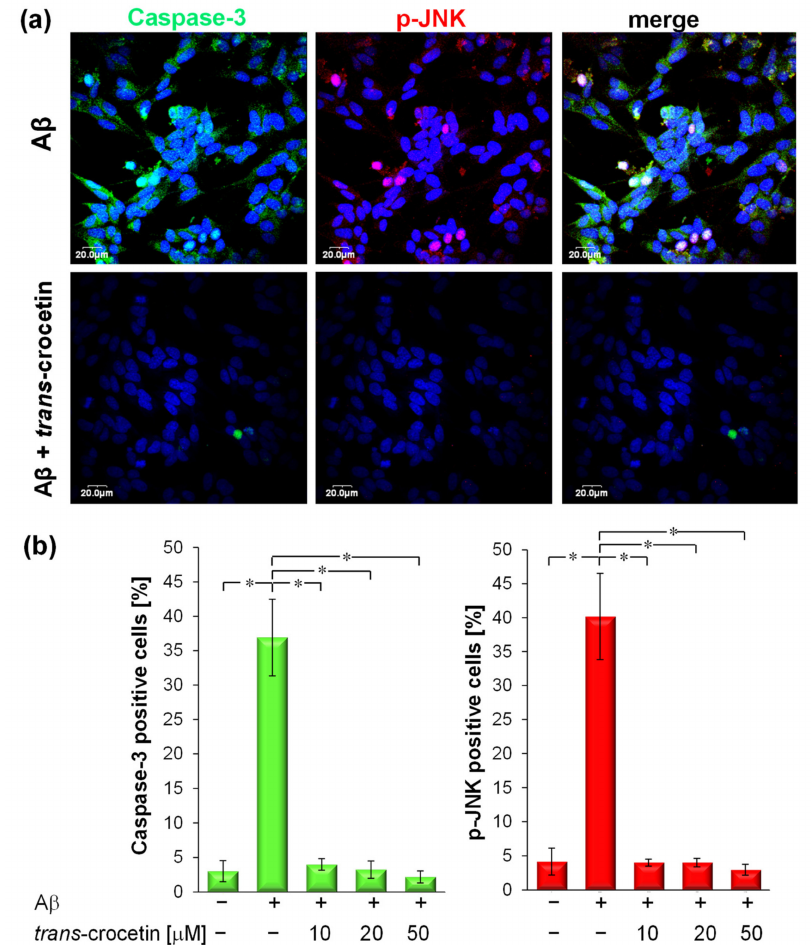
Figure 5. Trans-crocetin defended neurons against A β -induced apoptosis: ( a ) Confocal laser repre- sentative micrographs of neurons in the PLGA multiplex membrane platform after A β treatment and after co-treatment with A β and trans-crocetin 10 µ M. Cells were stained for apoptotic markers active Caspase-3 (green) and p-JNK (red), and nuclei (blue). ( b ) Quantitative analysis of apoptotic markers. The values, expressed as average ± SD, are the means of five experiments, and statistically significant data were evaluated according to an ANOVA followed a Bonferroni t -test ( p <0.05): * vs. other